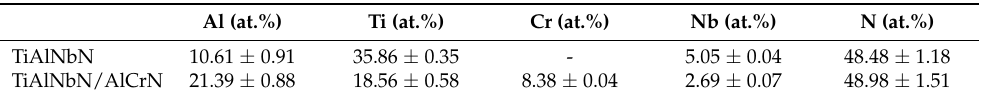
Table 2. Chemical composition of the deposited TiAlNbN and multilayered TiAlNbN/AlCrN coatings measured by